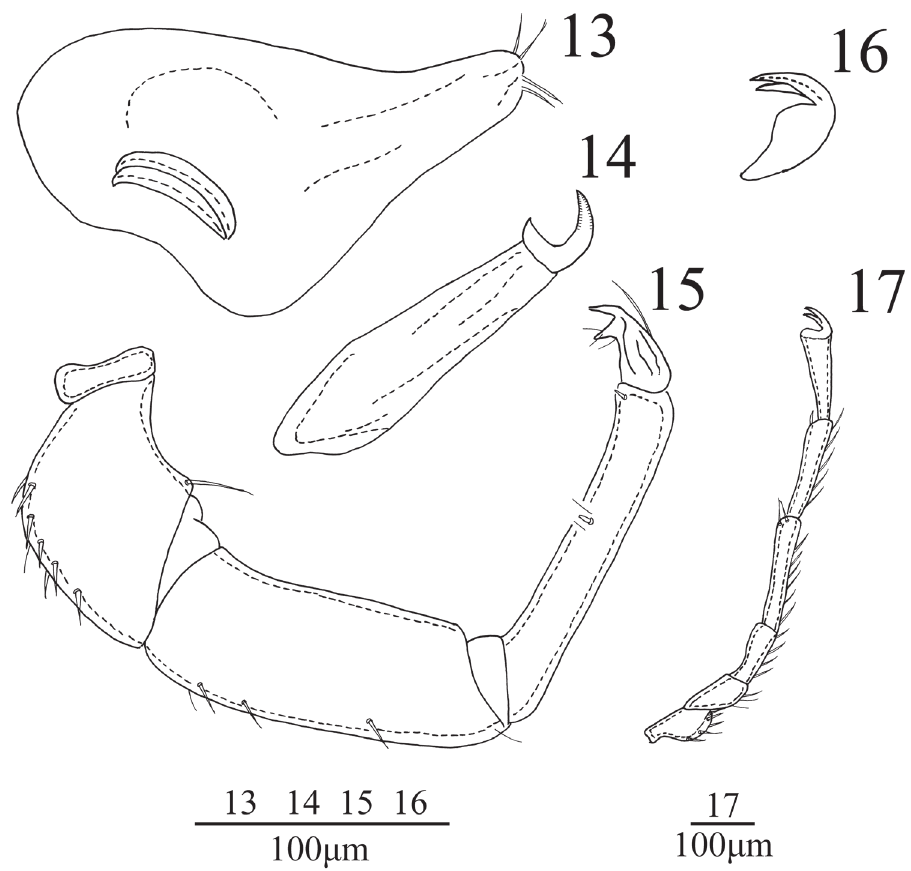
Figures 13–17. Sperchon rostratus Lundblad, 1969, Male 13 infracapitulum 14 chelicera 15 palp 16 claw 17 IV-L-1–IV-L-6.